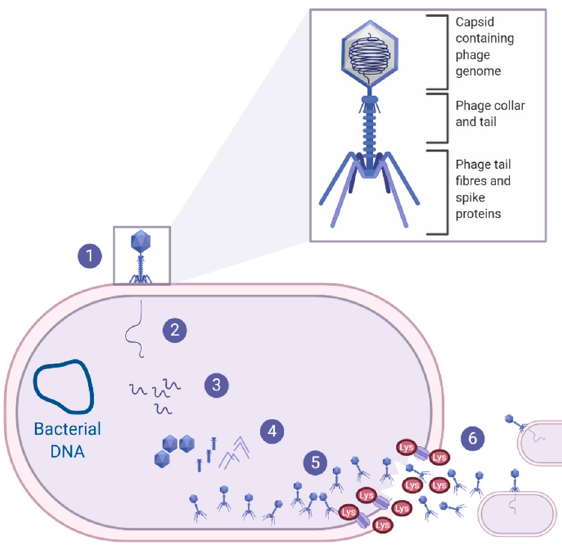
Figure 2. The lytic life cycle. Lytic bacteriophages undergo the lytic life cycle, which is initiated by ( 1 ) phage adsorption, in which the phage tail fibres recognise and attach to the bacterial outer membrane receptors. This results in an irreversible attachment of the phage to the bacterial surface which causes ( 2 ) the contraction of the phage tail sheaths to puncture the outer membrane and cell wall, allowing the phage genomic material to pass from the phage capsid to the bacterial cell via the phage tail. ( 3 ) The phage DNA is replicated using the bacterial host cell machinery and is subsequently ( 4 ) transcribed and translated into new viral components (e.g., capsid, tail, tail fibres). ( 5 ) Newly synthesised viral components will assemble to become mature virions which will secrete proteins known as holins and endolysins. ( 6 ) Holins will create a pore in the bacterial membrane, allowing the endolysins to pass through and degrade the peptidoglycan layer. This results in bacterial cell lysis, releasing hundreds of mature phage virions that will continue to infect and lyse neighbouring bacterial cells [119,120].